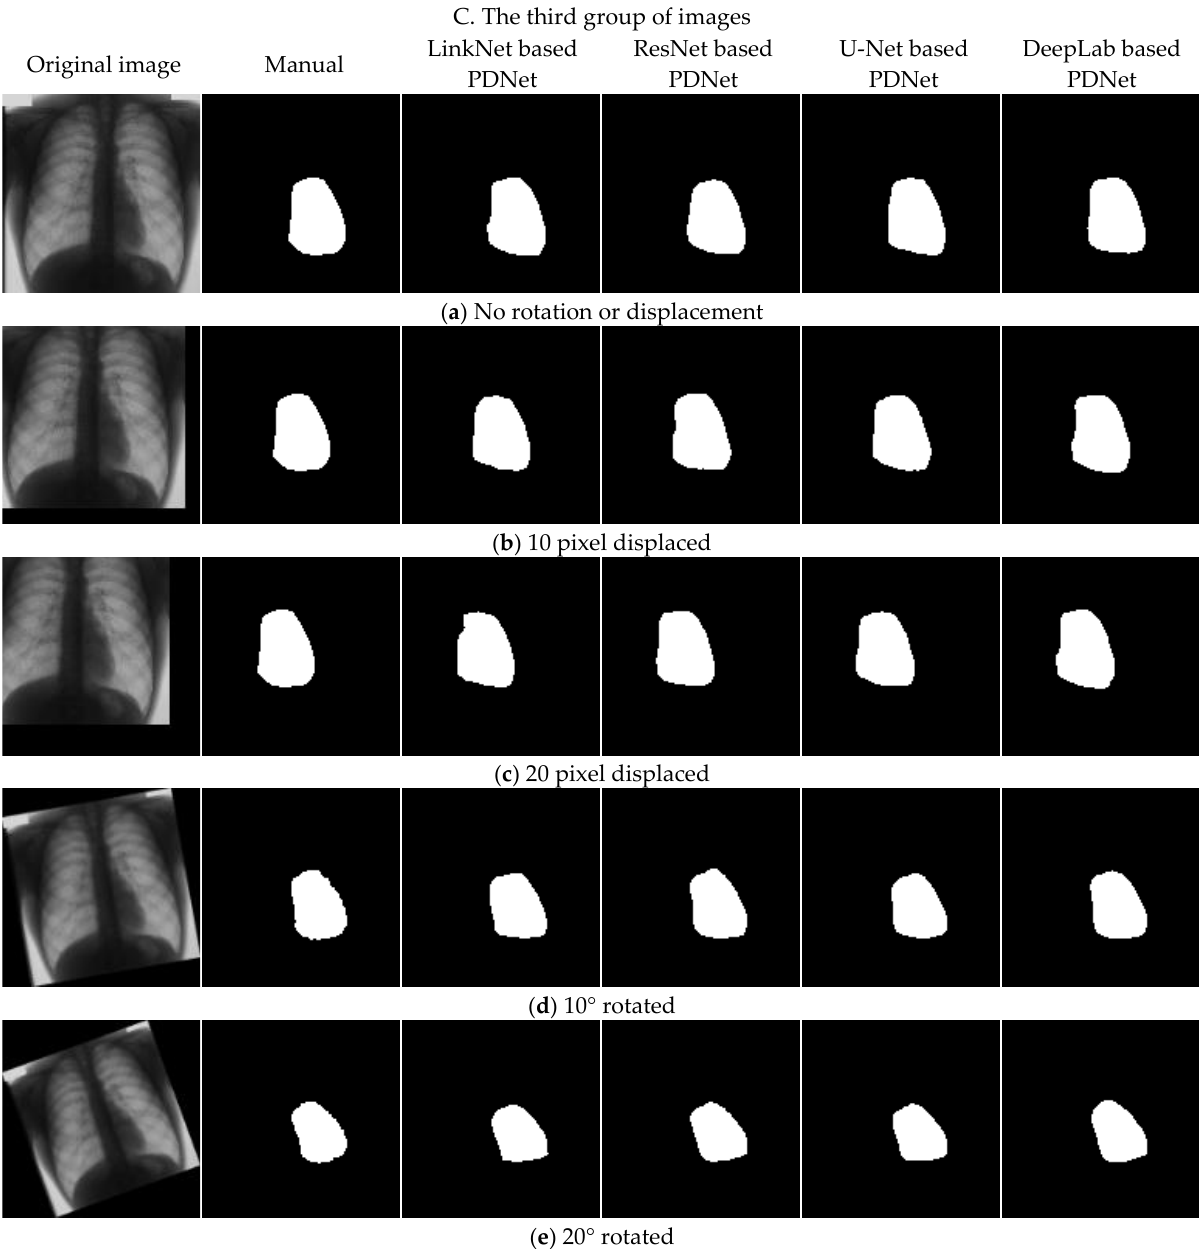
Figure 11. Three groups(A,B,C) of segmentation results. Table 1. Evaluation results of the network (Unit: %, keep two decimals). The PQ column represents the parameter quantity of the network. The PMIoU column shows the results of cardiac segmentation obtained from the other literature [50], serving